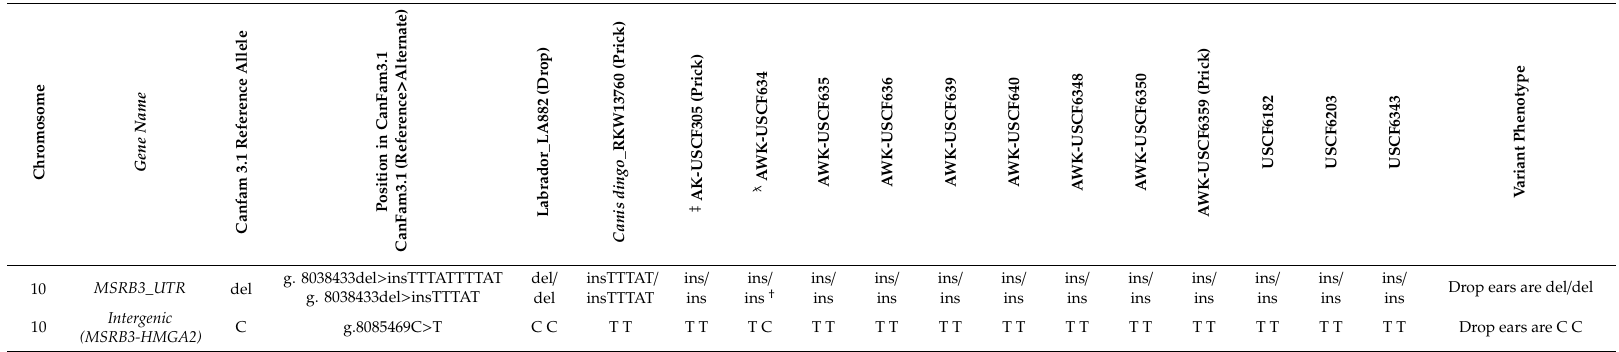
Table 3. Segregation of an insertion polymorphism in the functional candidate gene MSRB3 3’ untranslated region ( MSRB3 _UTR) with pricked ear in 12 Kelpies, one Dingo, and one Labrador